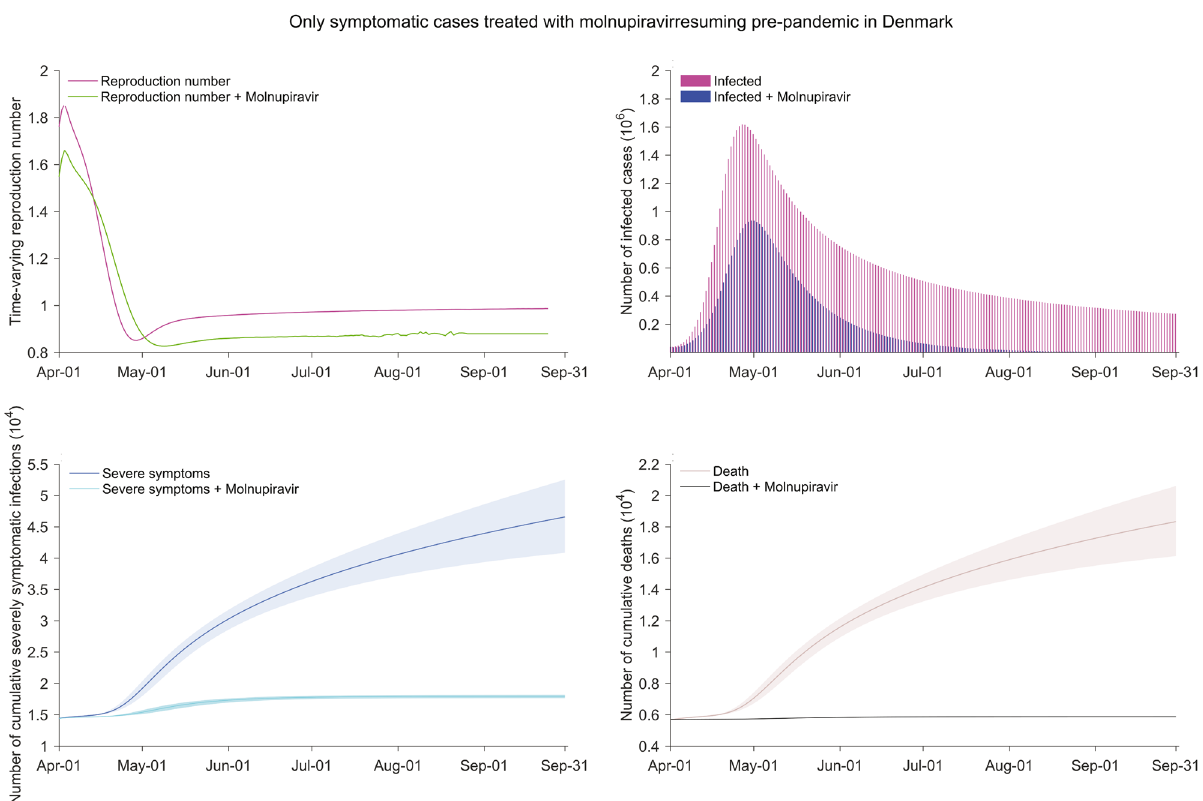
Figure 8. The impact of molnupiravir treating nonhospitalized patients with symptoms resuming pre- pandemic social activities in Denmark. Treatment with molnupiravir after the onset of signs or symptoms in nonhospitalized cases. The social activity level is in accordance with mixing patterns in social networks before the COVID-19 pandemic. The number of infected cases represents the current situation of existing infected ones including asymptomatic carriers and active patients. The settings of the reinfection proportion, dominating pango lineages, the treatment implementation time, and the molnupiravir treatment effectiveness for individuals are identical to those in Fig. 4. The shadow parts represent the 95% confidence interval related to